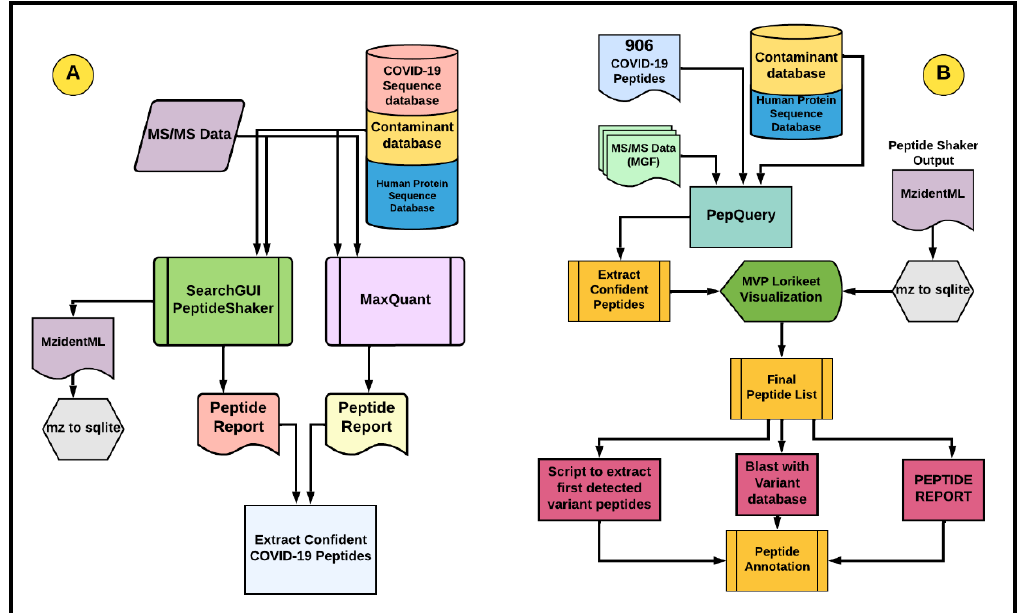
Figure 2. Galaxy-based workflows were used to identify and verify SARS-CoV-2 peptides from MS-based clinical datasets. ( A ) Discovery workflow: MS/MS spectra from clinical datasets were searched against a database consisting of SARS-CoV-2 structural protein sequences from SARS-CoV-2 variants, wild-type virus protein sequence, common contaminant sequences, and human protein sequences using SearchGUI/Peptide Shaker and MaxQuant. The PSM output was filtered to extract confident matches to COVID-19 peptides with sequences unique to viral variants. mzidentML generated from SearchGUI-Peptide shaker was used for spectral quality analysis via Lorikeet viewer. ( B ) Verification Workflow: A peptide panel of 906 SARS-CoV-2 peptides (theoretical and empirically detected peptides obtained from in silico analysis, cell-culture, and clinical datasets including variant- specific peptide sequences) was subjected to the PepQuery analysis of clinical MS datasets. The